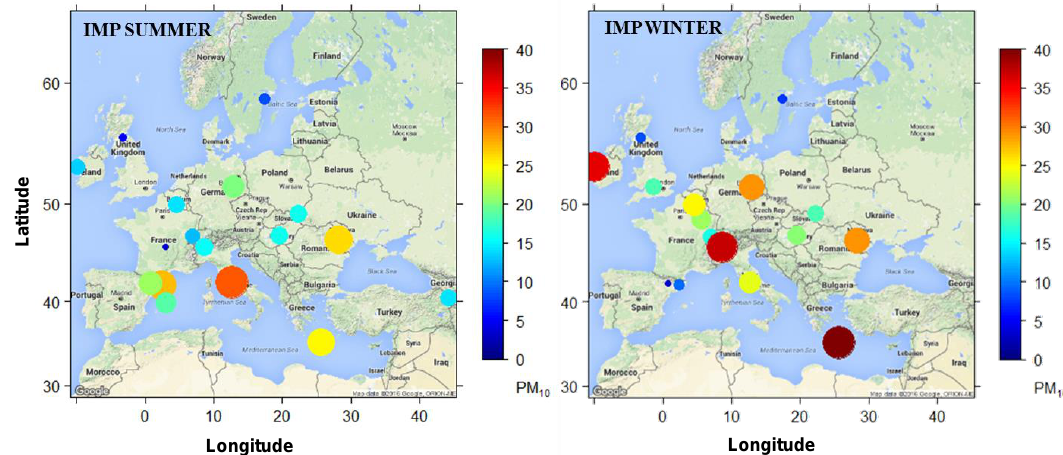
Figure 2. Mean PM 10 concentrations (µgm − 3 ) recorded during the June/July 2012 and January/ February 2013 EMEP IMPs. The diameter of the circles is proportional to the